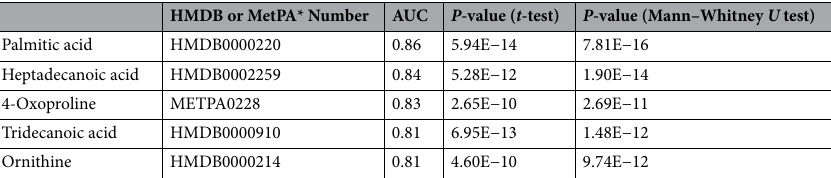
Table 2. Five most significant metabolomic biomarkers for lung cancer screening. *MetPA (Metabolomic Pathway